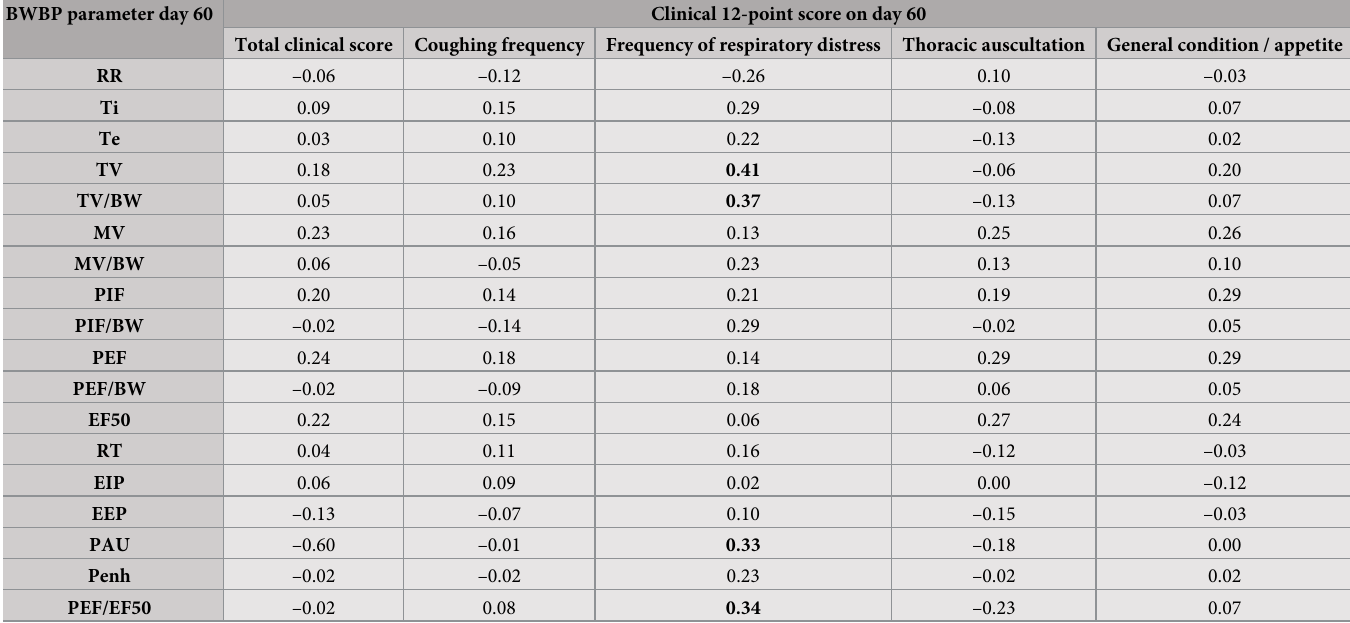
Table 8. Correlation coefficients r between the clinical 12-point score and the individual BWBP parameters on day 60. BWBP parameter day